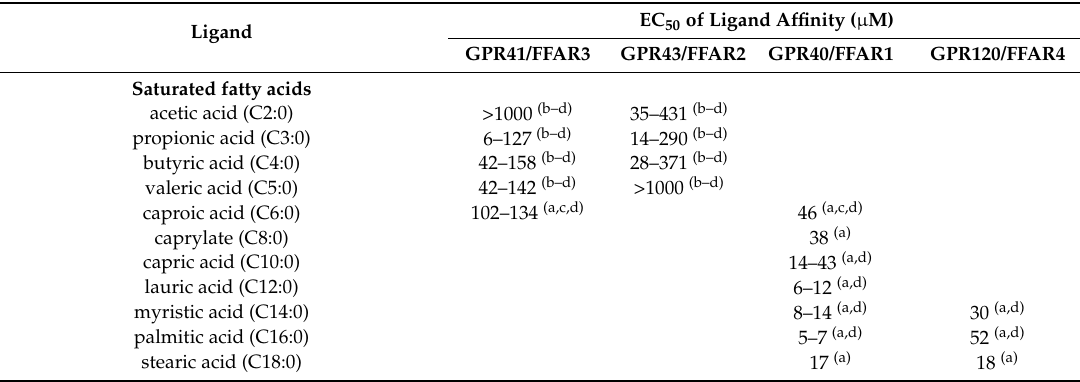
Table 1. Affinity of free fatty acids for GPR41, GPR43, GPR40 and GPR120